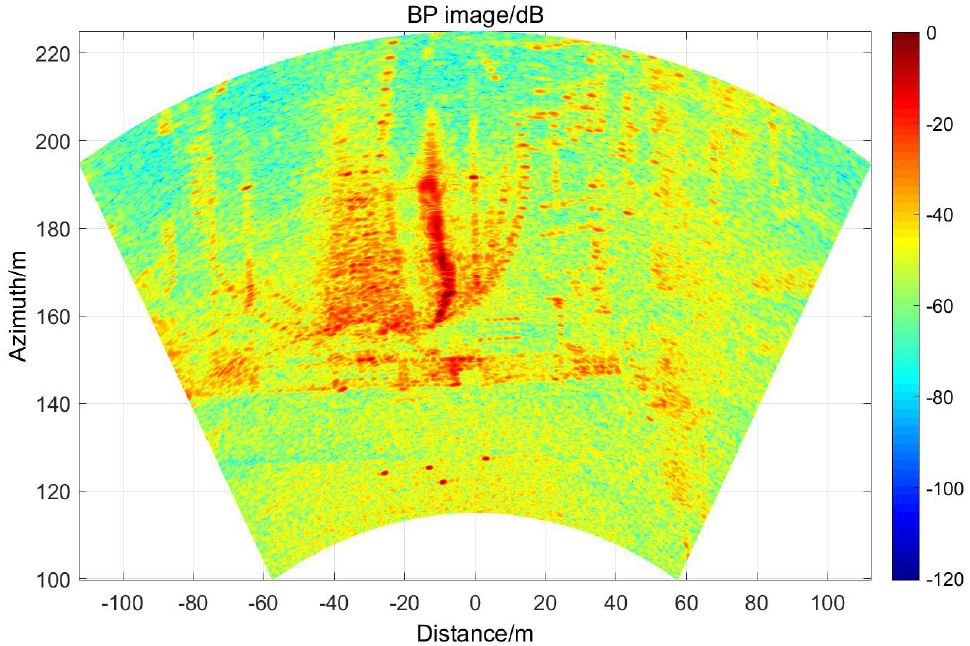
Figure 20. Image of the scene.